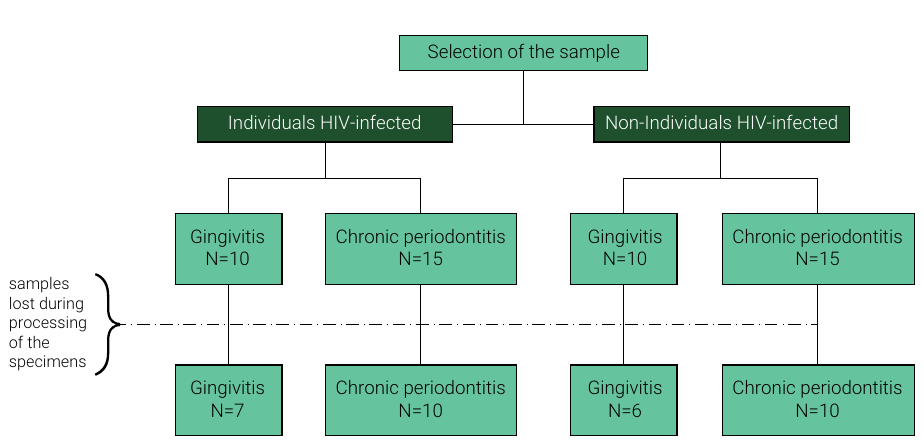
Figure 1. Sample selection